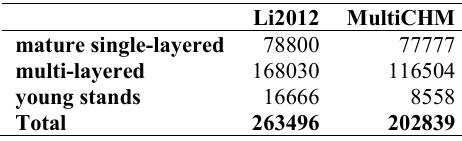
Table 5. Total volume m 3 /ha for all strata.